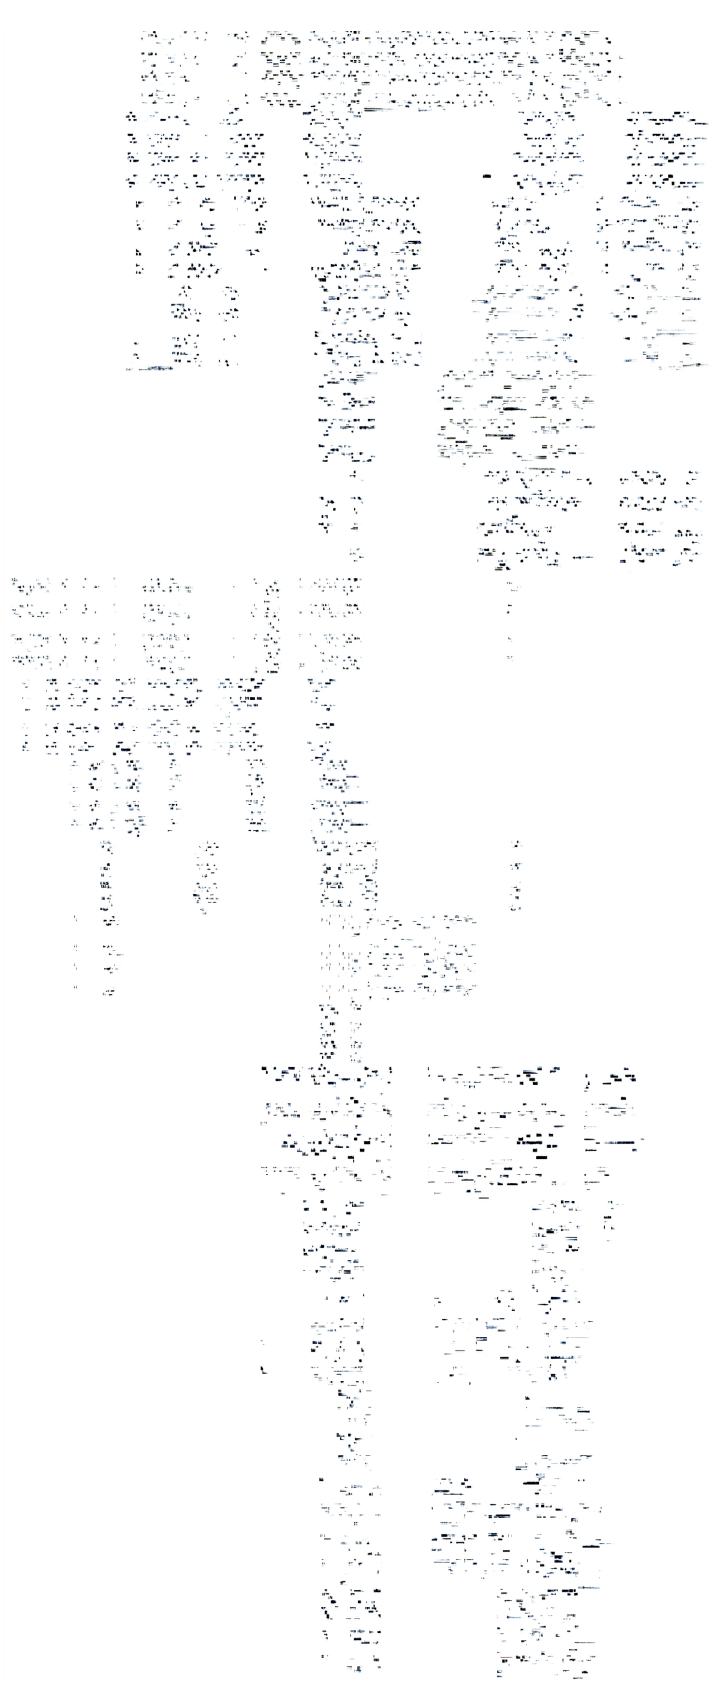
Figure 4 | Timeline showing sonogram arrangement of sounds in Leere Null . Time passes horizontally and concurrent sounds are vertically